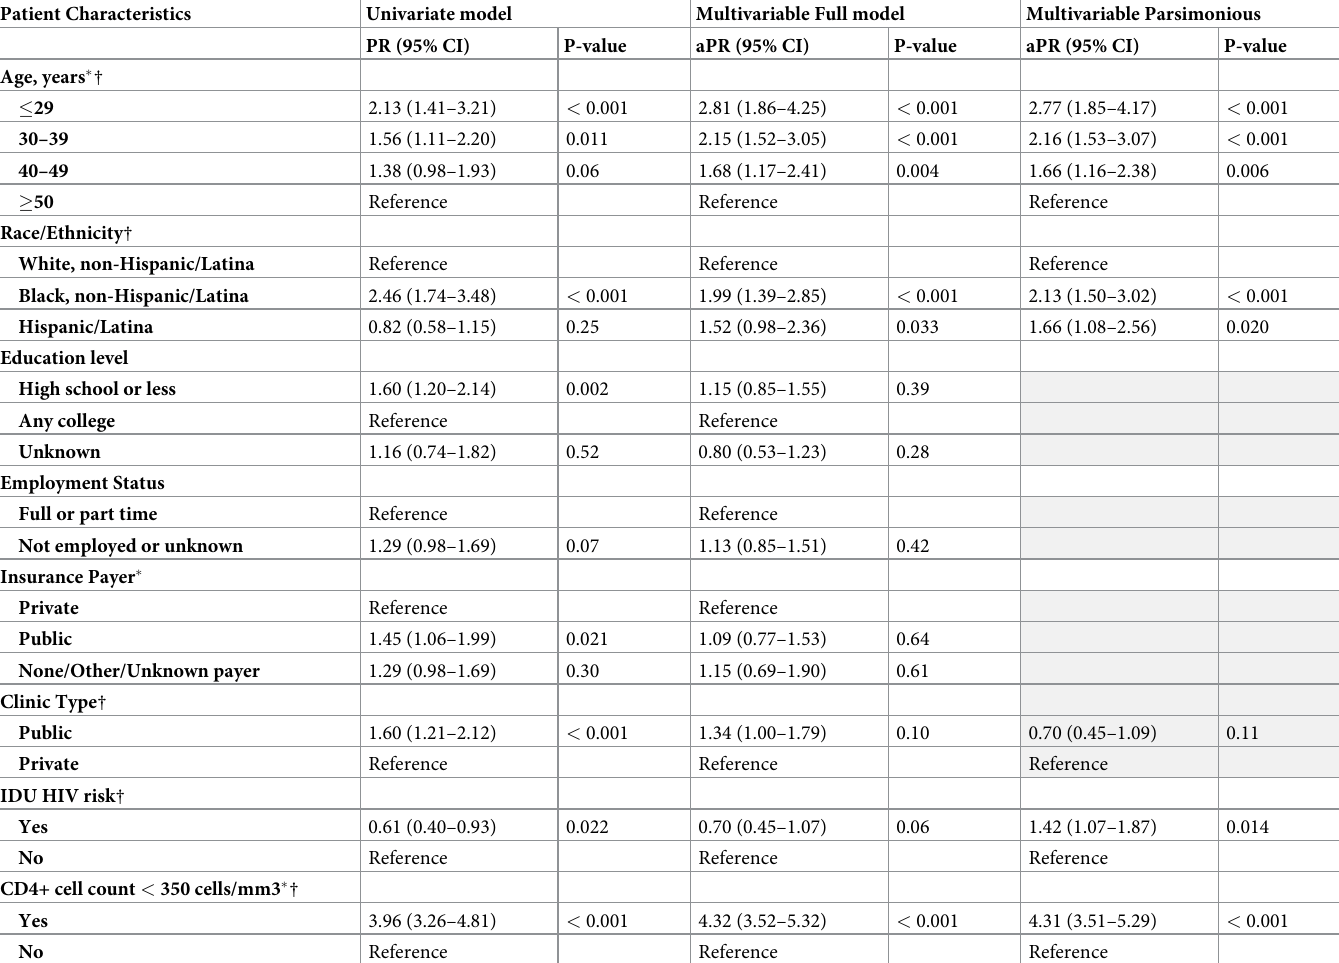
Table 3. Generalized estimating equation analyses of factors associated with not having viral suppression when prescribed ART, the HIV Outpatient Study, 2010– 2015 (N =